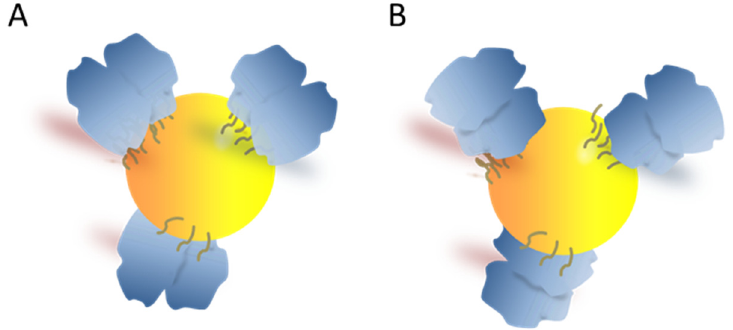
Figure 7. Different conformations of conjugates. ( A ) Both VuFeSOD monomers bind to the nanoparticles ( B ) one of the monomers binds to the NPs and the other does not.